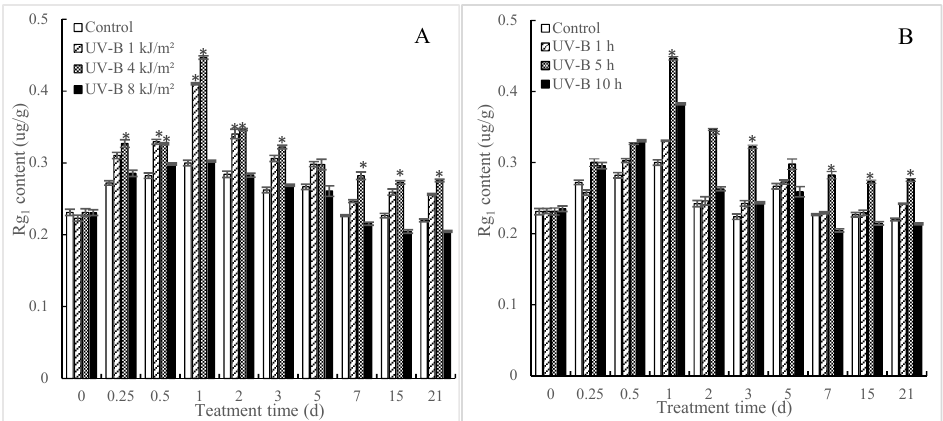
Figure 1. E ff ects of UV-B irradiation on Rg 1 content. The P. quinquefolius roots that were irradiated with di ff erent doses of UV-B ( A ) or irradiated with 4 kJ / m 2 UV-B for di ff erent times ( B ) were taken for measuring the accumulation of Rg 1 in P. quinquefolius roots during a 21-day postharvest drying process. Data are means of three replicates ± SD. Asterisks show significant di ff erences ( p < 0.05, t -test) for the samples between UV-B treatment and control sampled at the same time point according to one-way ANOVA followed by Student–Newman–Keuls tests ( p < 0.05).